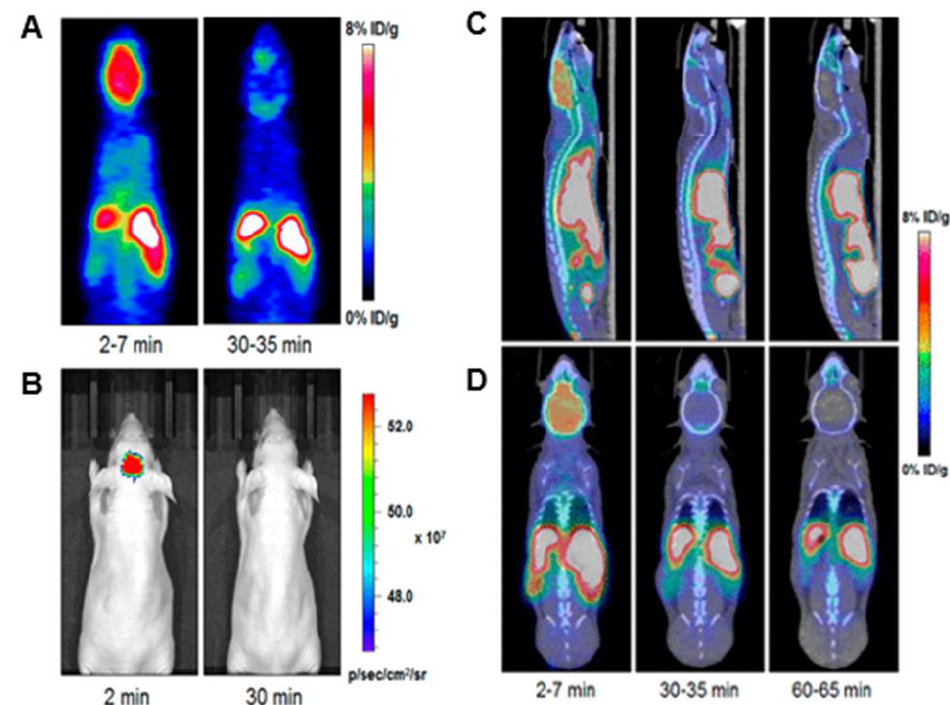
Figure 7. Radioactive fluorine exchange in BODIPY used for PET, compound 27 . ( A ) PET imaging and ( B ) optical imaging was done at two intervals: 2 min and 30 min (0.1 GBq/µmol). ( C ) and ( D ) indicate MicroPET/CT images at the same intervals with an additional image at 60 min; ( C ) sagittal view and ( D ) coronal view (0.8 –1 GBq/μmol). Figure used with permission from [ 39]. Copyright 2019 American Chemical Society.